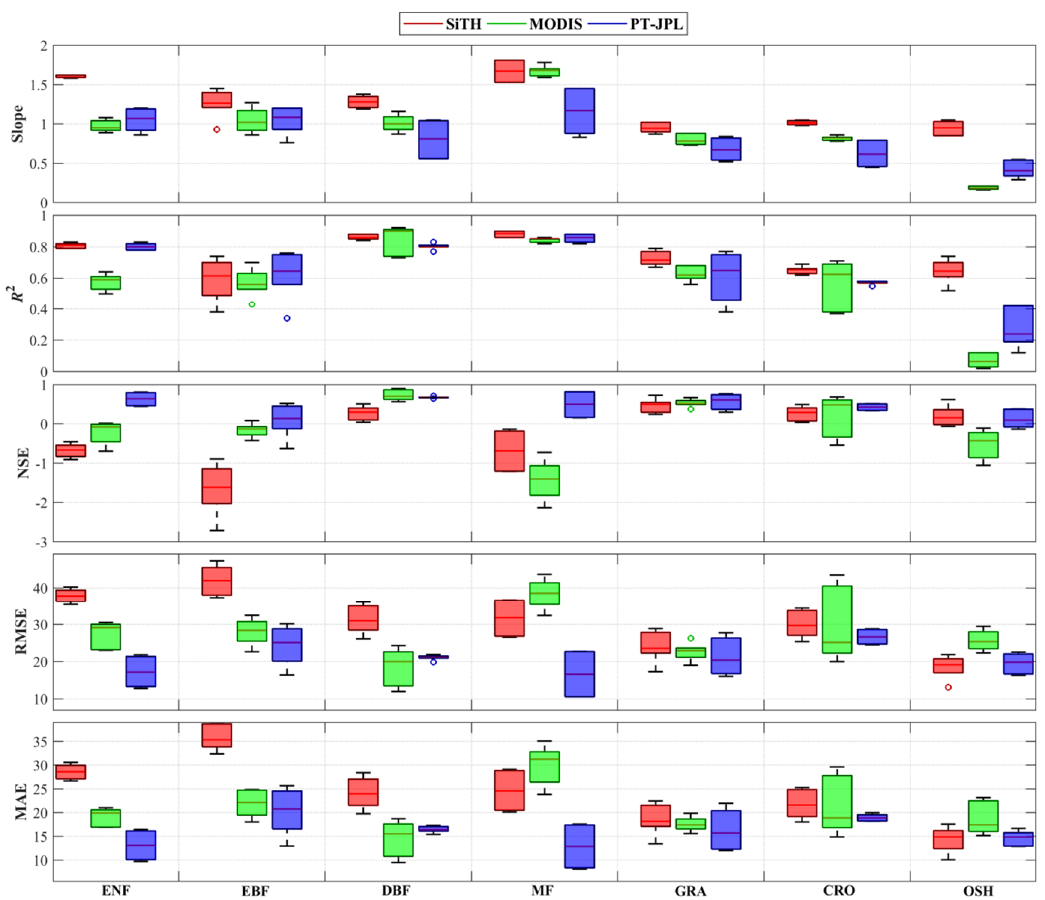
Figure 3. Comparison of the simulated ET by three models using different forcing datasets versus observed ET at different biomes. Boxplots show the slope, R 2 and NSE statistical significance of simulated ET. The central solid line of each box shows the median. The bottom and top of boxes represent the 25th and 75th percentiles, respectively. The lower and upper whiskers indicate the minimum and maximum values, respectively. The circles represent outliers.